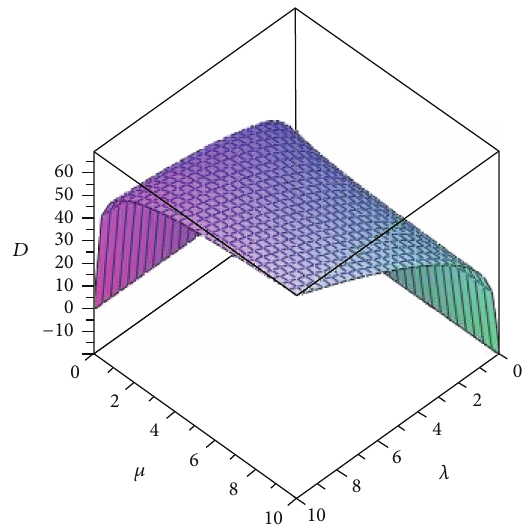
Figure 10: Profit difference between the systems with and without warning